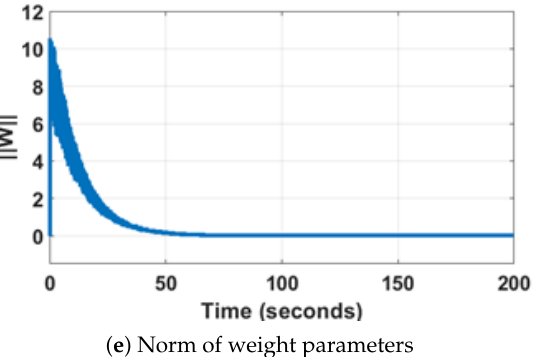
neously. As compared to the set point, the device reached the desired locations along x and y directions after about 30 and 50 s, respectively. The AUV could sink down the required depth after about 15 s while it rotated to the pre-set angle after approximately 40